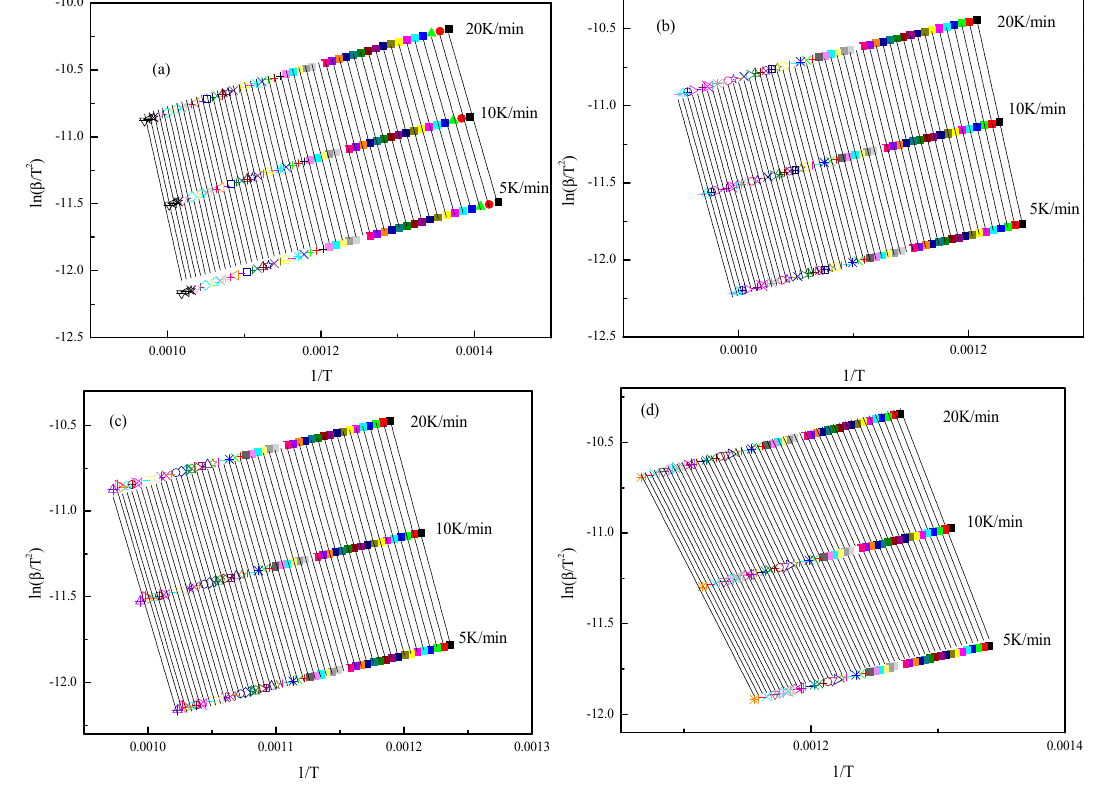
β 1 ) vs. 1 at a given fractional conversion at different heating rates: ( a ) RD; ( b ) C-1; ln( ) vs. at a given fractional conversion at different heating rates: ( a ) RD; T T 2 2 T T